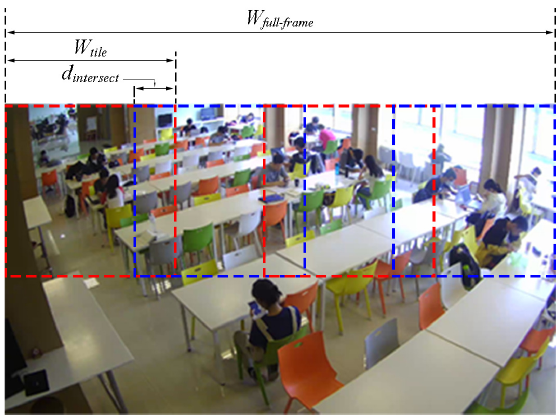
Figure 4. Illustration of tile images.